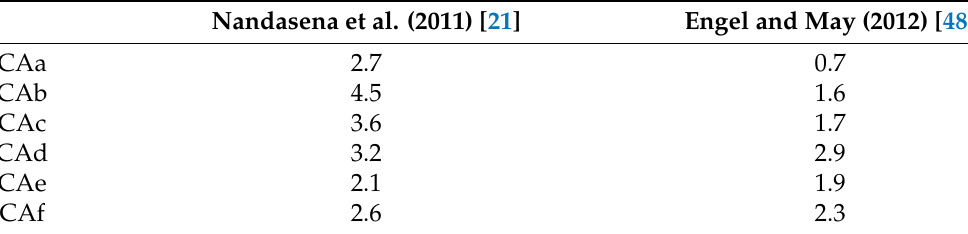
Table A23. Minimum wave heights H m (m) required to displace the boulders of the Capilungo coast.